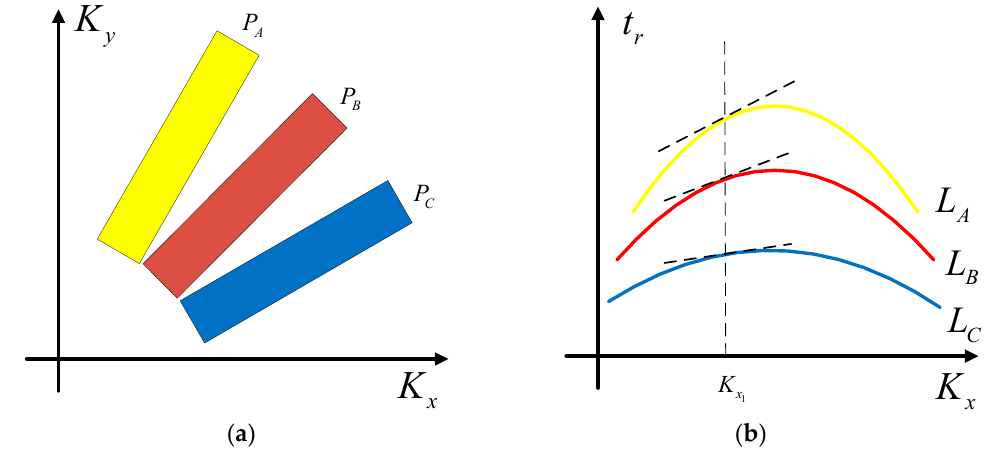
Figure 4. Geometry of the wavenumber spectrum analysis of the point A, B and C: ( a ) 2-D wavenumber support region of the targets; ( b ) Envelope of the targets in the azimuth wavenumber domain.